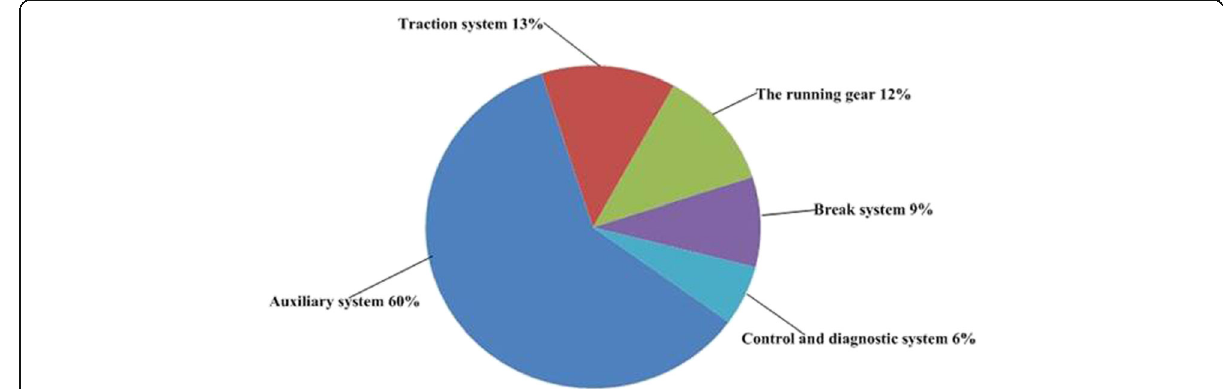
Fig. 3 Statistics of the operational failure of subway key components